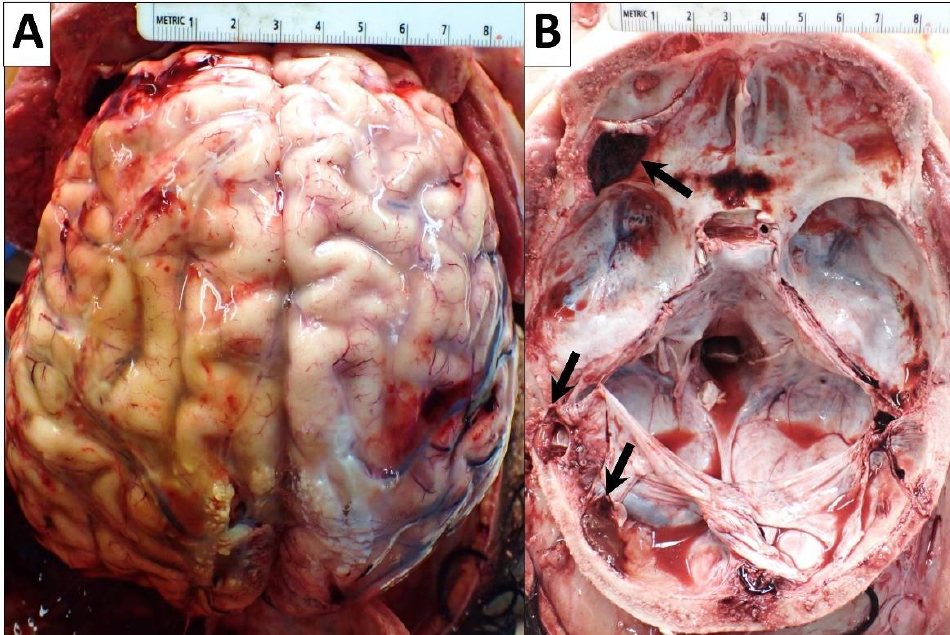
Figure 7. Gross images of the brain and skull. ( A ) Yellow discoloration of the convex left temporal and parietal surfaces of brain suggesting an extensive left temporal and parietal subdural hematoma (13 × 9 cm). ( B ) Base of skull (floor of the cranial cavity) showing scattered hematomas and clotted blood (black arrows).